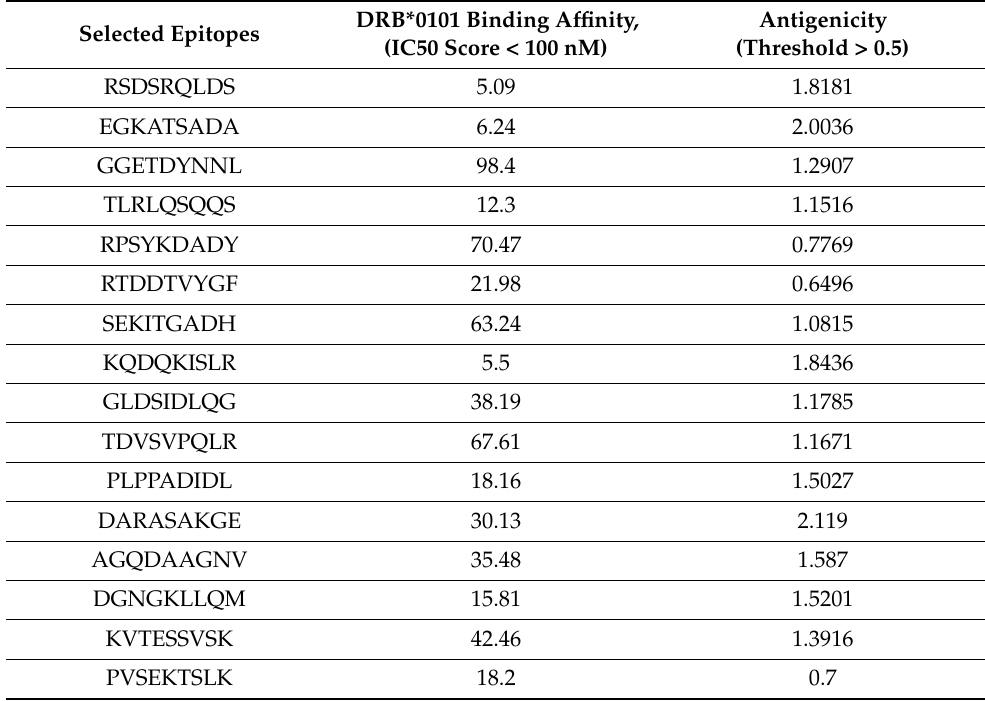
Table 1. Final shortlisted epitopes and their antigenic and IC50